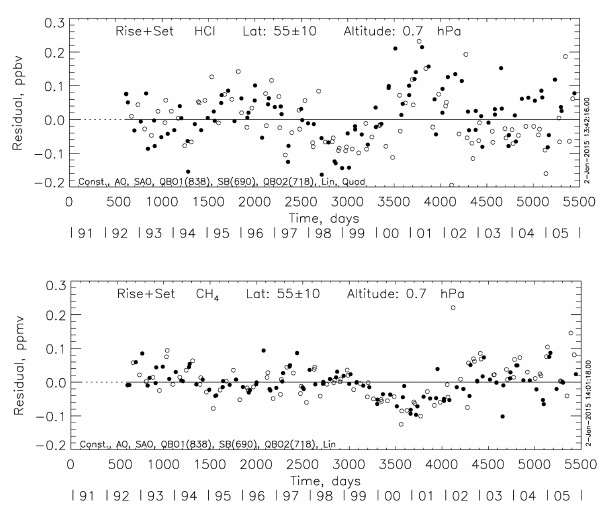
Figure 14. (Top) time series of HCl residual (data – MLR curve) at 0.7hPa and at 55 ◦ N; (bottom) time series of CH 4 residual at 55 ◦